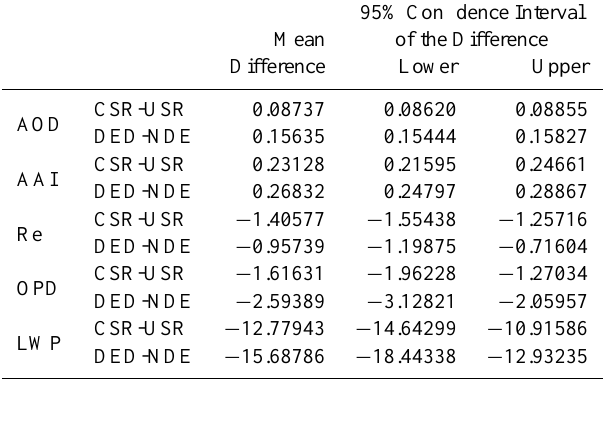
Table 1. Summary of Student-T test results for differences in aerosol and cloud properties between the CSR and USR, and CSR DED and CSR NDE.